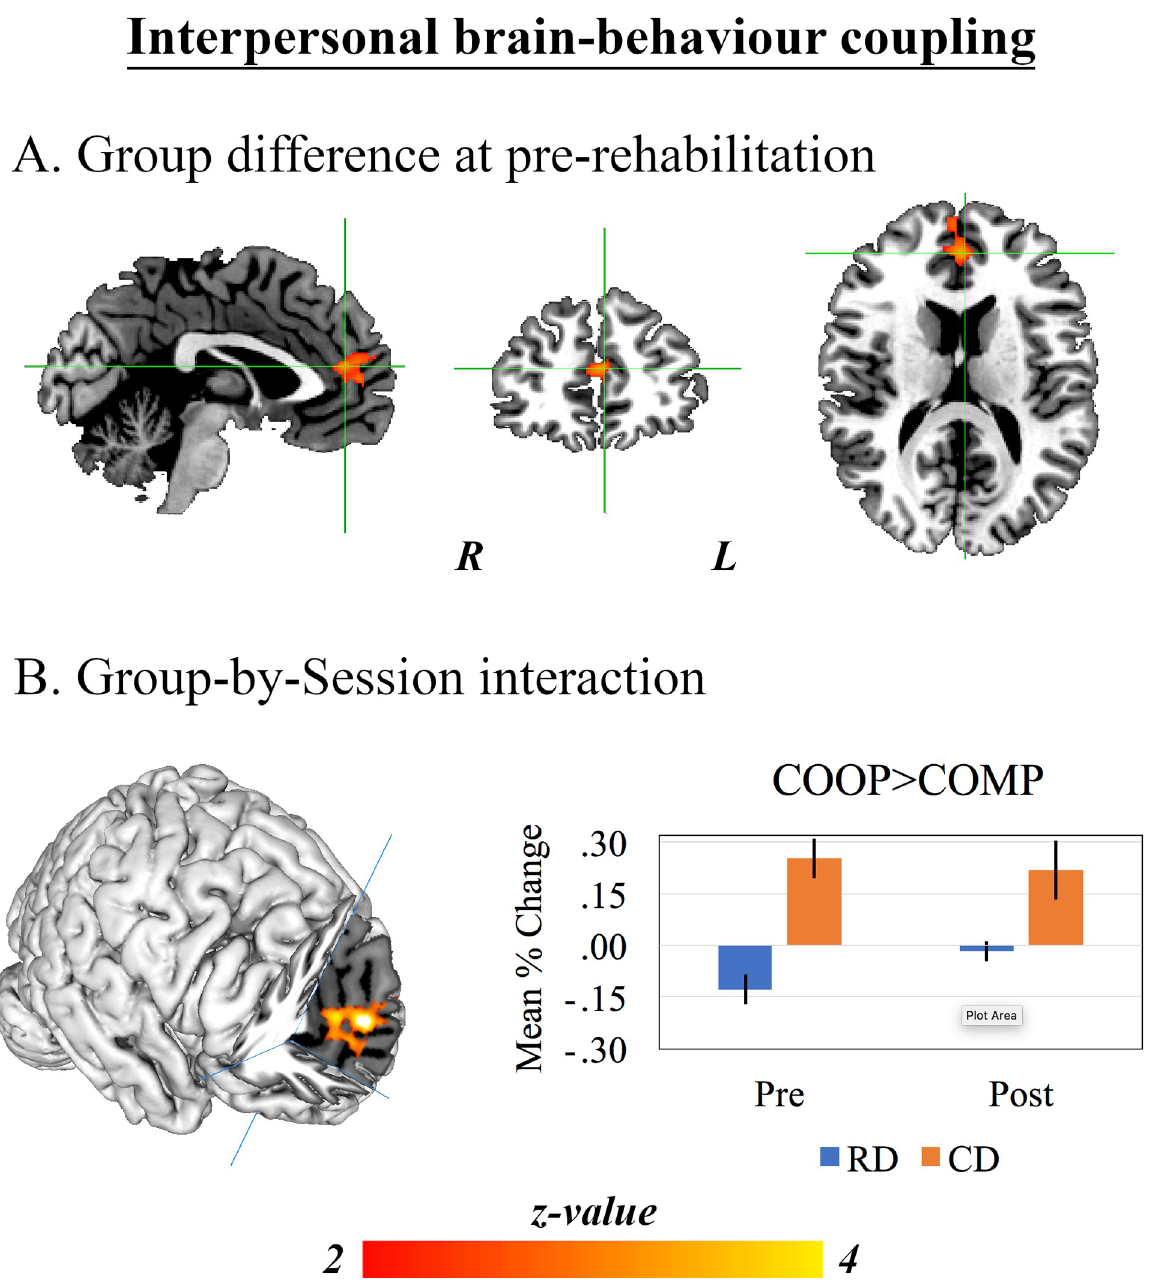
Fig 3. Results of the GLM analyses applied to data acquired during the interactive pattern game. A : The single cluster representing neural reactions to the behaviour of a co-player during pre-rehabilitation that were stronger in the COMP > CTRL contrast for RDs but the COOP > CTRL contrast in CDs. The whole-brain z-map is presented after non-parametric permutation inference involving 5000 permutations, thresholded at p < .05. B : The single cluster of brain response within the medial prefrontal cortex in which the [COOP > CTRL] vs . [COMP > CTRL] contrast expressed a Group-by-Session interaction at the uncorrected level ( p < .01), but did not survive non-parametric correction for multiple comparisons. This is presented only to illustrate our motivation for session-specific assessments of the Group effect, which revealed differences in and around this functional cluster at pre- but not post-program assessment after multiple-comparison correction (see